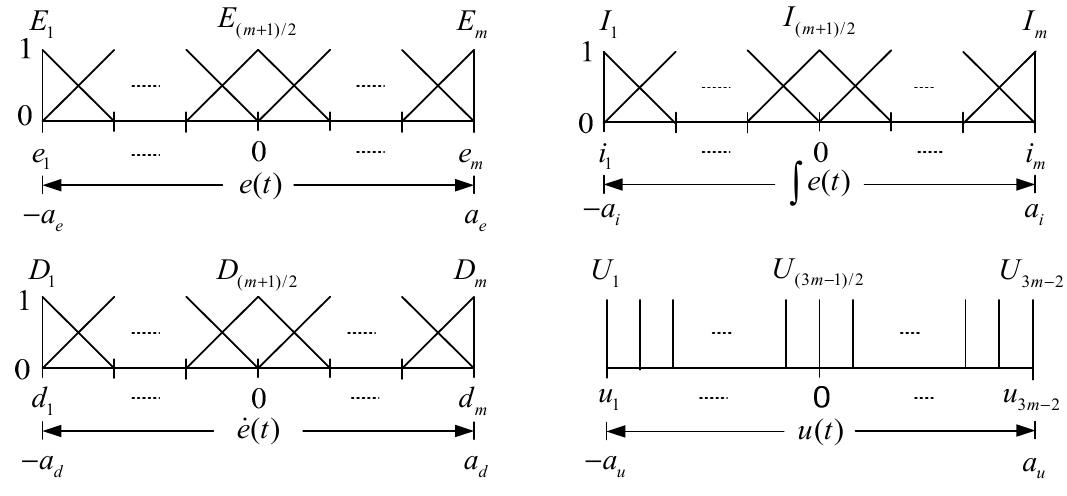
(cid:82) . e ( t ) , e ( t ) , and u ( t )